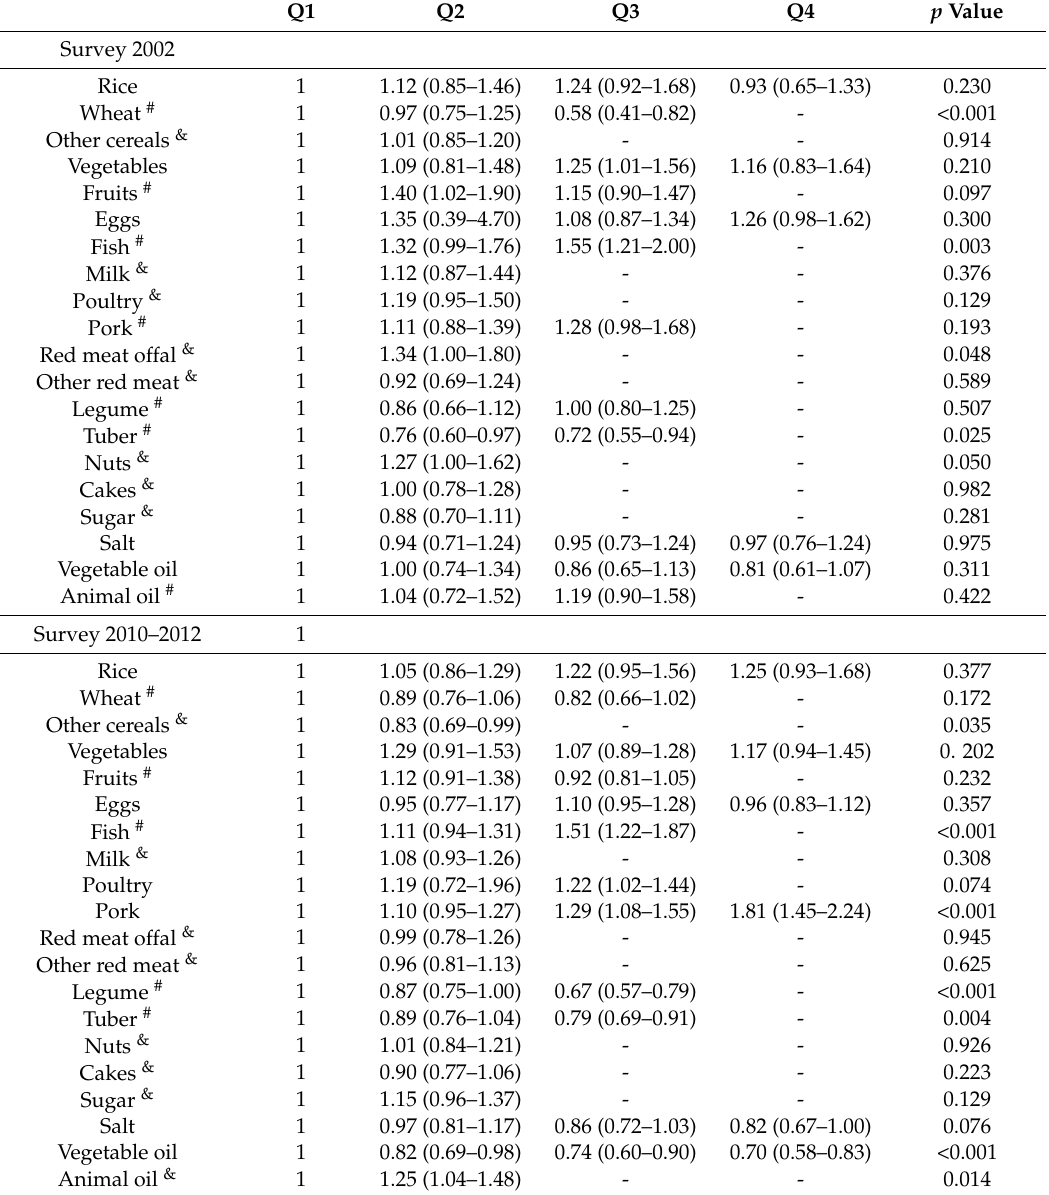
Table 5. Odds ratio (95% CI) for hypercholesterolemia by quartiles of individual food intake *.